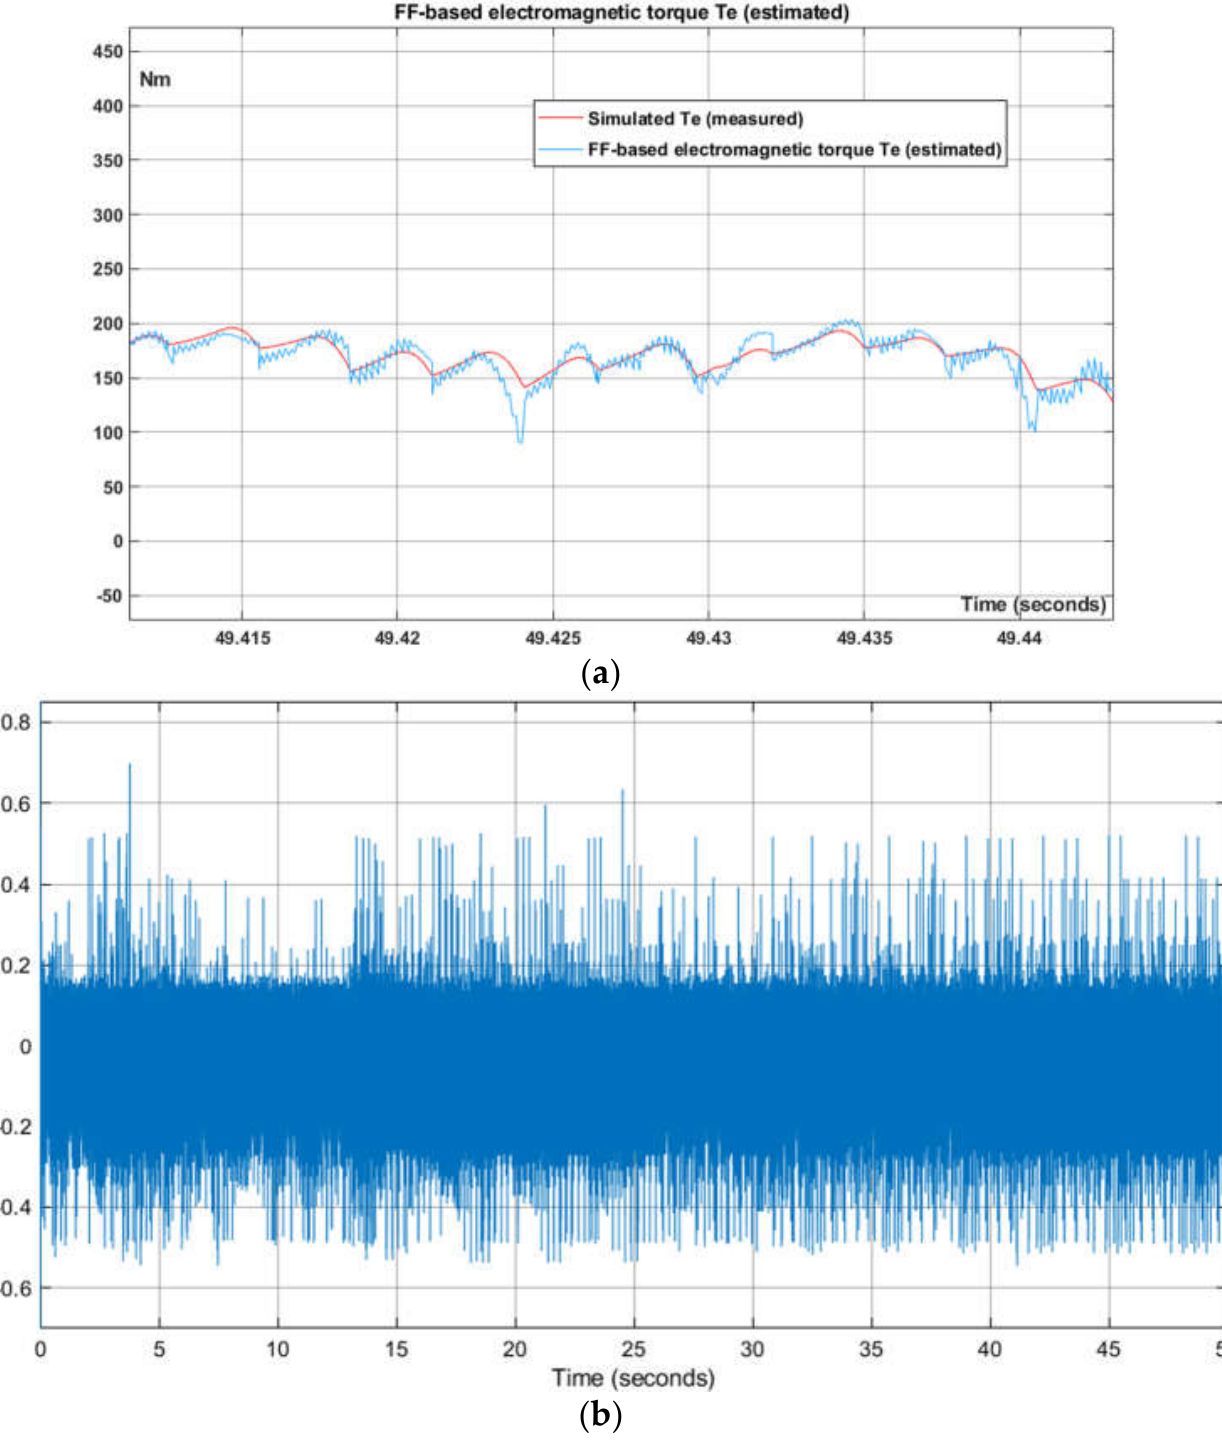
Figure 23. ( a ) Electromagnetic torque (orange) M e measured for training. M e -estimated (blue) by the ff ANN-based predictor; ( b ) M e error (scaled to 1.0) between measured and estimated electromagnetic torque for the rotor.